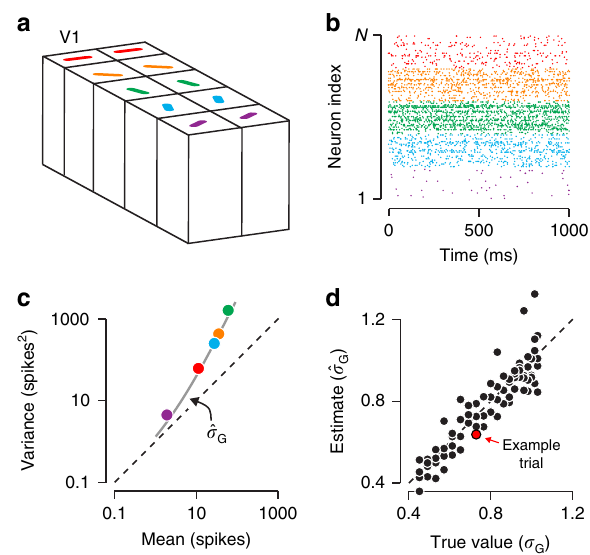
Fig. 9 Estimating gain variability in a neurally plausible way. a We simulated the activity of a population of 250 neurons (5 sub-populations of 50 neurons each, loosely based on the concept of cortical columns). All neurons within a sub-population had the same stimulus selectivity, and all neurons had the same uncertainty receptive fi eld, matching our empirical estimate. b Simulated population response for a single trial. Color indicates sub-population. c Variance-to-mean relation for a single trial. Points summarize responses grouped by sub-population, the line shows the predicted relation under the inferred level of gain variability, using the heuristic estimator. d Estimated gain variability plotted against ground truth. Stimuli varied in strength, and hence elicited different levels of gain